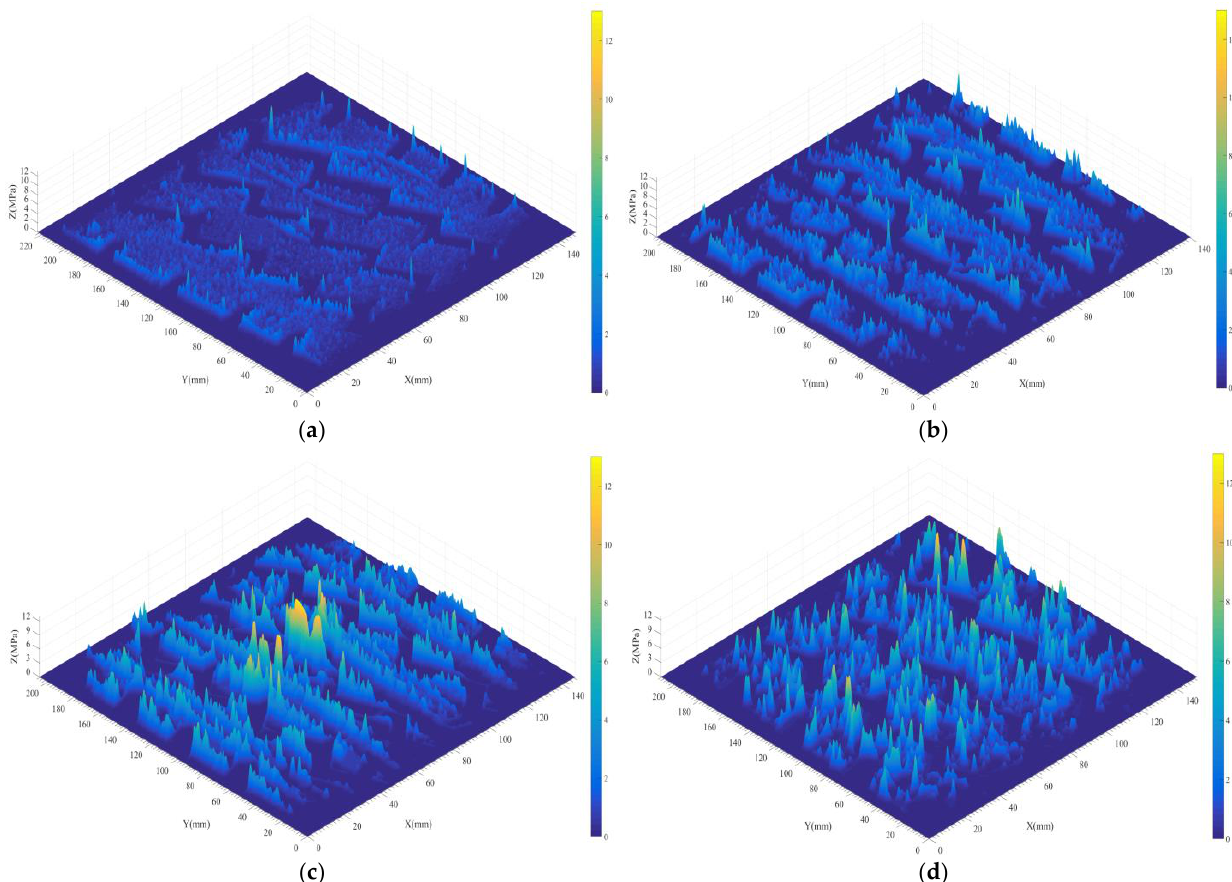
Figure 4. Tire contact stress of different pavements: ( a ) concrete pavements with no grooves, ( b ) rectangular grooves, ( c ) curved grooves, ( d ) asphalt pavement without grooves.